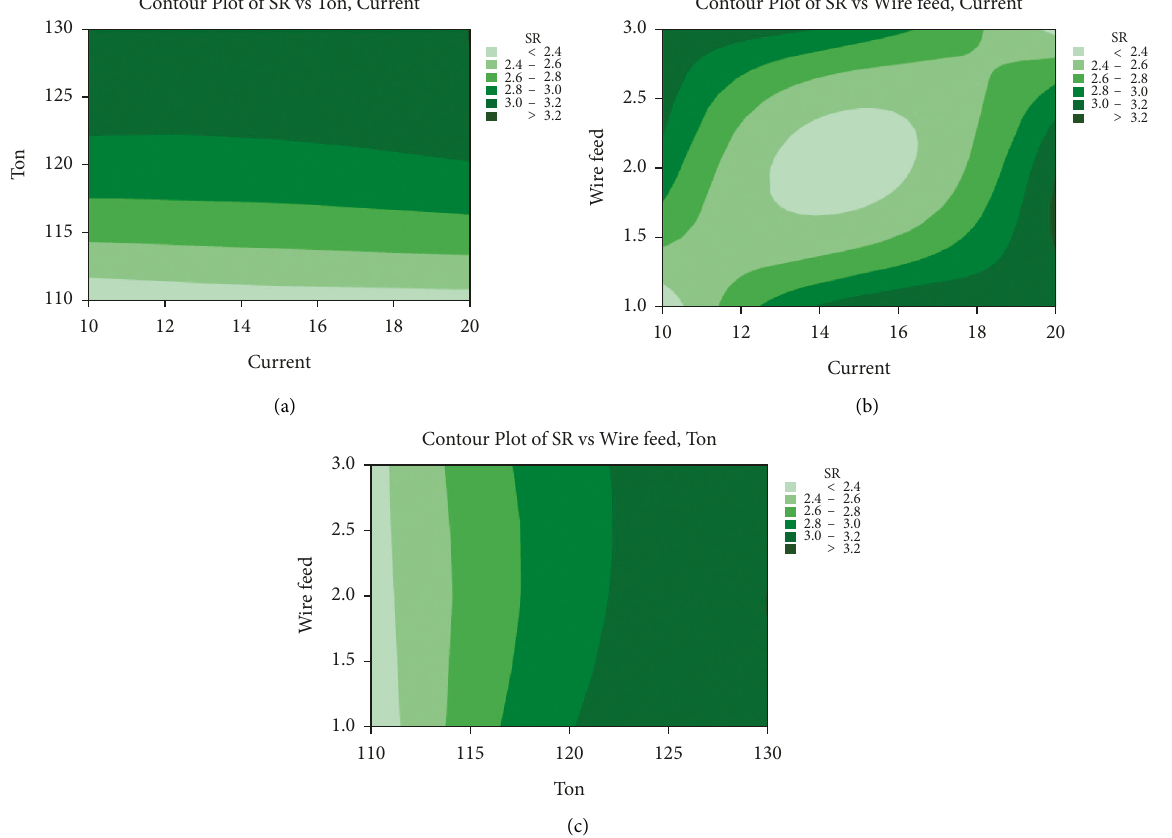
Figure 6: Contour plot for R a : (a) T ON and current, (b) wire feed and current, and (c) T ON and wire